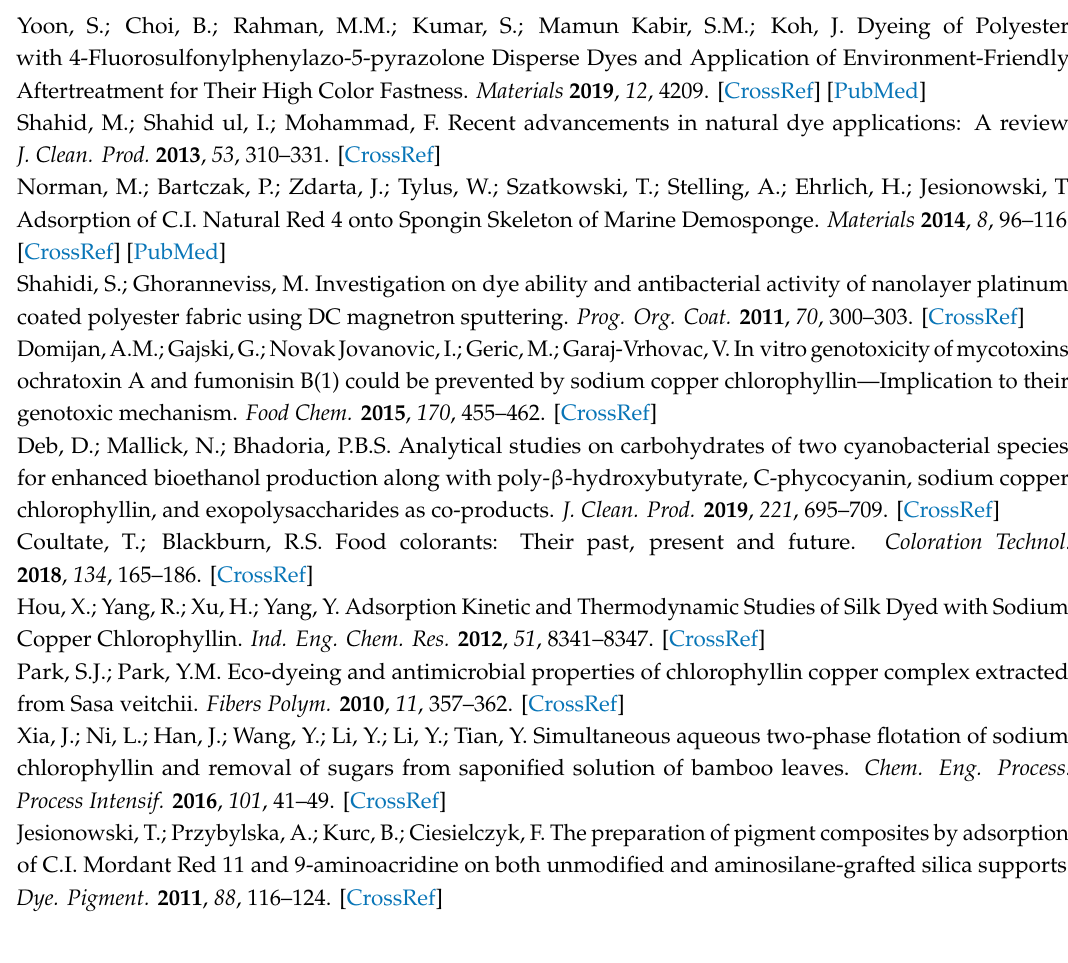
Figure S1: Diagram of the dipping and padding process, Figure S2: Yellowing of the pre-treated fabric, Figure S3: Captured contact angle images for green samples C (control) and 1–9 (samples 1–9 in the orthogonal design), Figure S4: High-resolution Cu 2p spectra of (a) SCC-dyed fabric and (b) post-treated fabric, Figure S5: Scheme of reaction of cross-linking chitosan to cellulose by citric acid, Table S1: Color strength (K / S) and CIE color coordinates of three pieces of SCC-dyed fabric obtained under the optimal pre-treatment conditions and dye concentration, Table S2: Color strength (K / S) and CIE color coordinates of the SCC-dyed fabric with and without the post-treatment, Table S3: Color strength (K / S) and CIE color coordinates of the untreated control and the 9 samples which have been subject to the